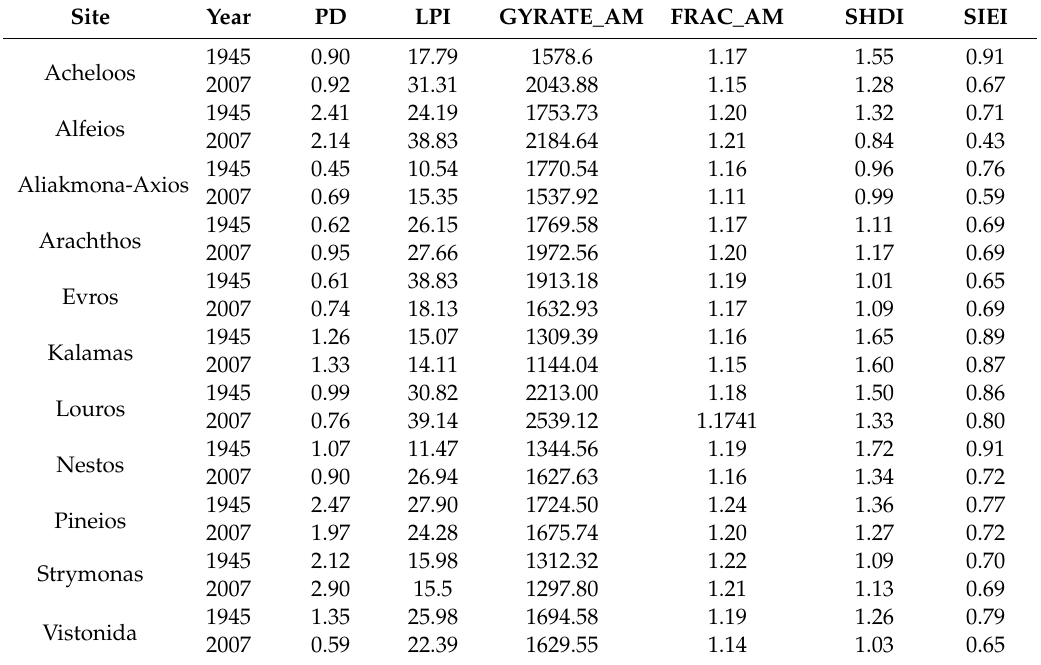
Table 2. Landscape structure metrics for each delta and year studied. PD: patch density; LPI: large patch index; GRYRATE_AM: area weighted mean radius of gyration; FRAC_AM: area weighted mean patch fractal dimension; SHDI: Shannon’s diversity index; SIEI: Simpson’s evenness index.